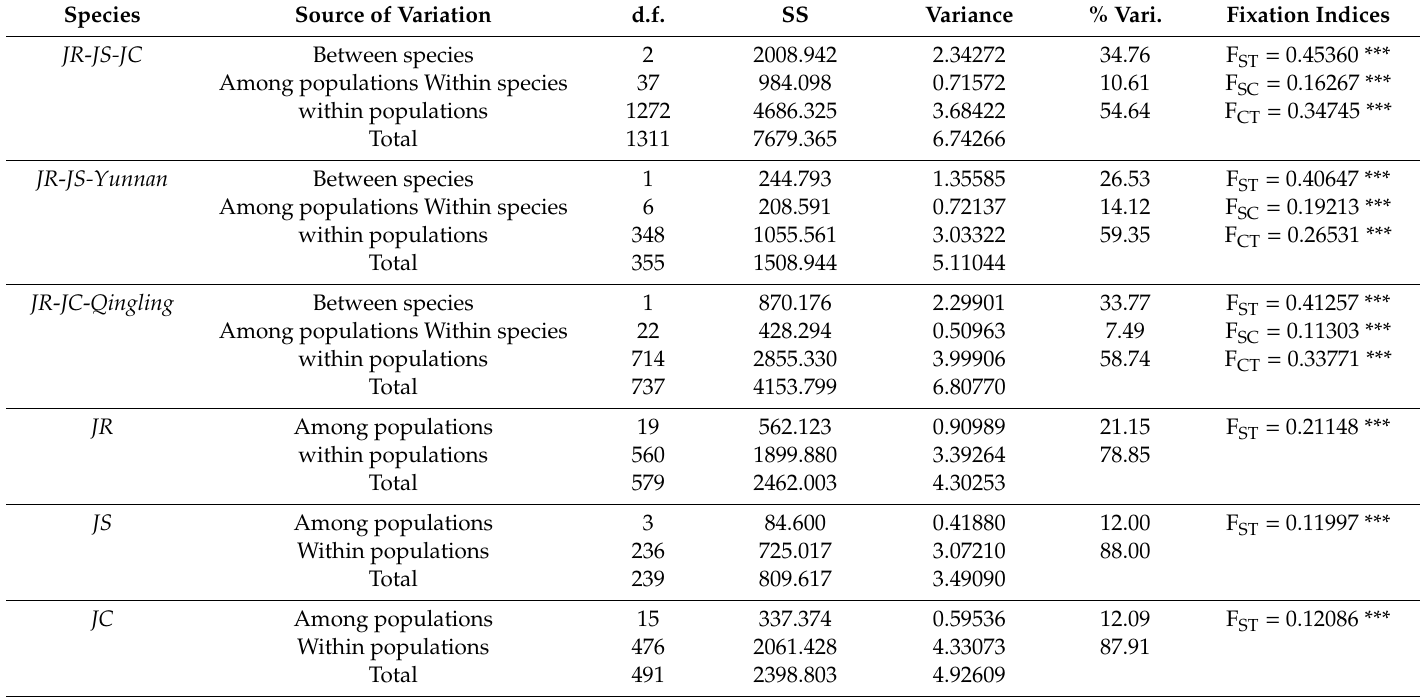
Table 2. Hierarchical analyses of molecular variance (AMOVA) of walnut samples based on 17 EST-SSR loci. Species Source of Variation d.f. SS Variance % Vari. JR -